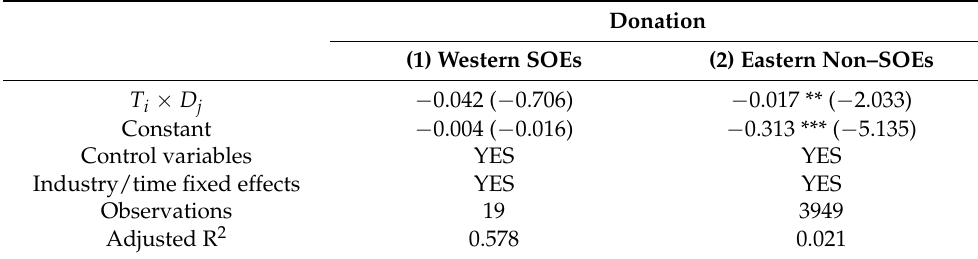
Table 10. Results of the effect of ownership differences combined with regional